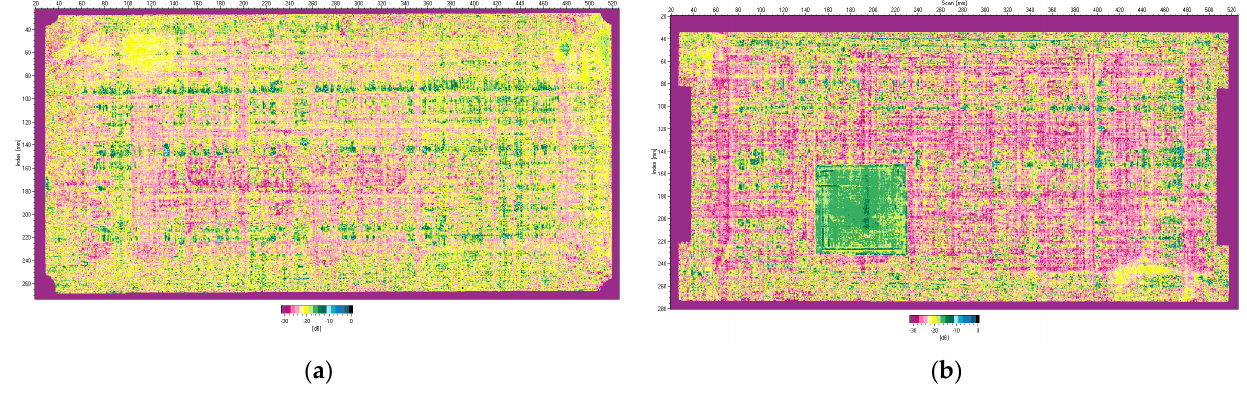
Figure 4. Ultrasonic C-scan (time-of-flight mode) images of the plates: ( a ) healthy plate; ( b ) plate with an artificial delamination.